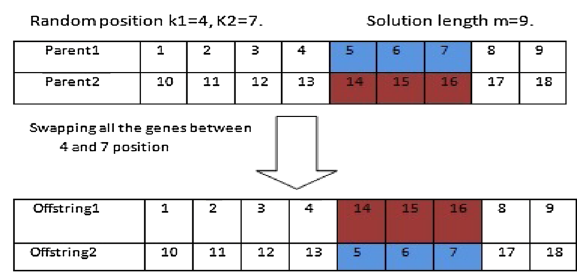
Fig. 4 Two-point crossover operation